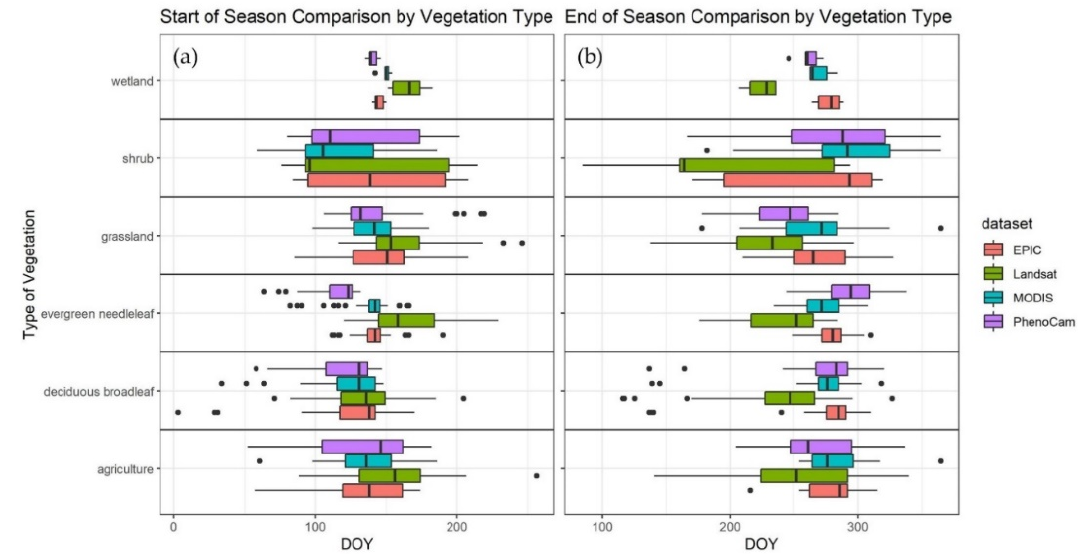
Figure 5. Derived ( a ) SOS and ( b ) EOS from PhenoCam, Landsat, MODIS, and EPIC for years 2016, 2017, and 2018, displayed for different land cover types.